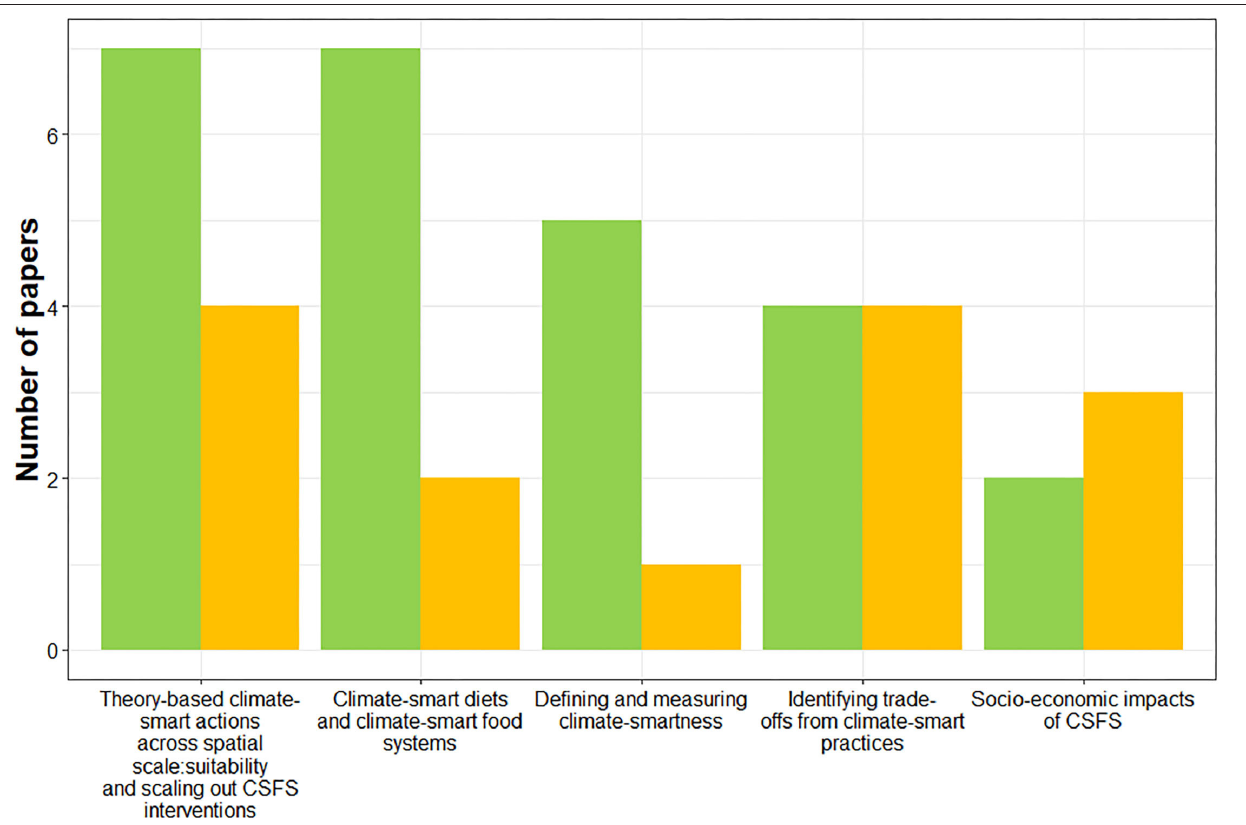
FIGURE 1 | Summary of recent literature addressing either indirectly or partially (amber bars) and directly (green bars) the research questions identified by Whitfield et al. (2018). The first column combines two of the Whitfield questions. The underlying analysis of the way in which each paper contributes to the research question can be found in Supplementary Table 1 . The analysis in this figure focuses primarily, but not exclusively, on publications in the Climate-Smart Food Systems section of Frontiers in Sustainable Food